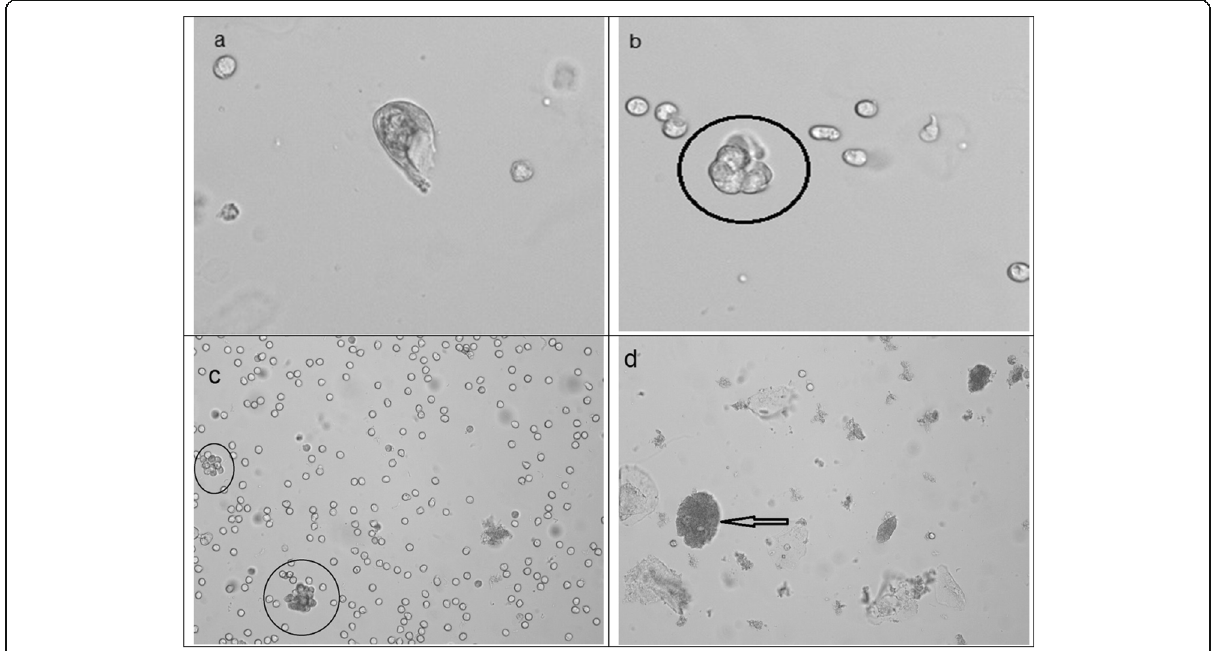
Fig. 1 Original high power field digital images of Sysmex UD-10 unit are seen. A single atypical cell ( a ) and a group of atypical cells ( b ) belonged to the sample taken from the male patient with a high grade urothelial carcinoma. Sysmex UF-4000 flow cytometry unit gave 5.7 atypical cells/µL result for the patient. In ( c ) a crowded sample from a 26 years old female patient was seen. Almost all cells were white blood cells that formed a clump of cells as reported by the instrument. Her result was 5.5 atypical cells/µL. A 51 years old female patient showed a large number of squamous epithelial cells some of which were covered with bacteria ( d ). Her result was 13.7 atypical cells/µL. Samples of these two female patients were examined by digital images taken by UD-10 unit and by manual microscopy of stained slides. No atypical cells were